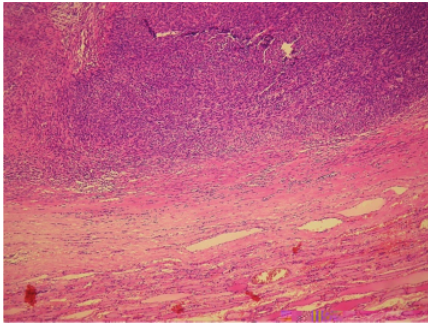
Figure 2: Hematoxylin-eosin staining, 400x, markedly tumorous, numerous polymorphs, tumorous cells.